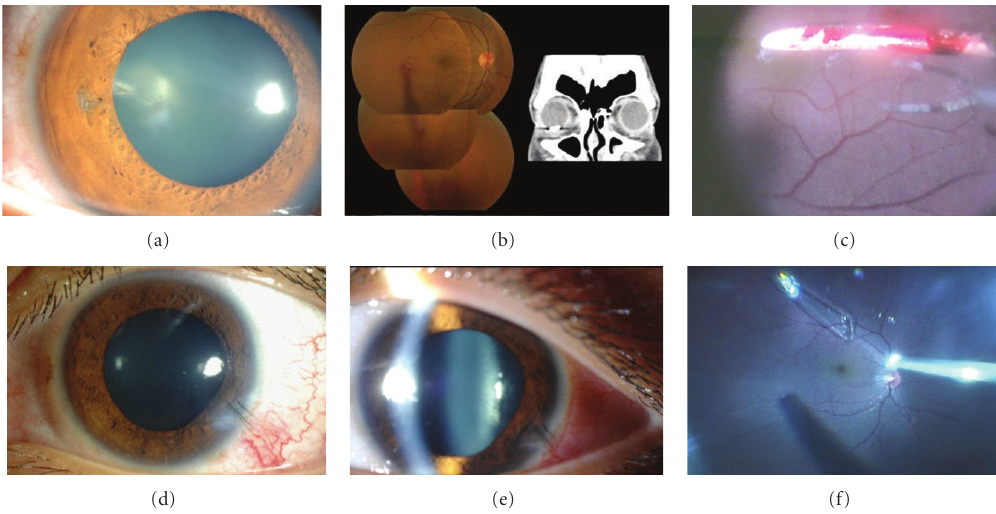
Figure 1: Preoperative slit-lamp photographs, preoperative fundus photograph, preoperative computed tomographic image, and intraop- erative photographs of intraocular foreign body (Case 1; (a, b, c), Case 2; (d, e, f)). (a) Preoperative slit-lamp photograph shows a slight penetrating wound in the iris and lens at the 9 o’clock position and a posterior subcapsular cataract at the same position. (b) Fundus photograph showing vitreous haemorrhage and retinal tear with subretinal haemorrhage located on the temporal side of the macula. Computed tomographic image showing a large foreign body. (c) Intraoperative fundus showing a large metallic intraocular foreign body anterior to the retina. (d) External photograph showing the penetrating wound at the 4 o’clock position and the corneal wound was closed by corneal sutures during the initial surgery. (e) Slit-lamp photograph showing that the posterior subcapsular cataract has progressed. (f) Intraoperative fundus photograph showing large glass intraocular foreign body anterior to the